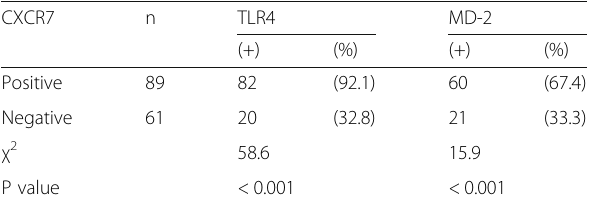
Table 3 The correlation between the expression of CXCR7 and TLR4 and MD-2 in gastric